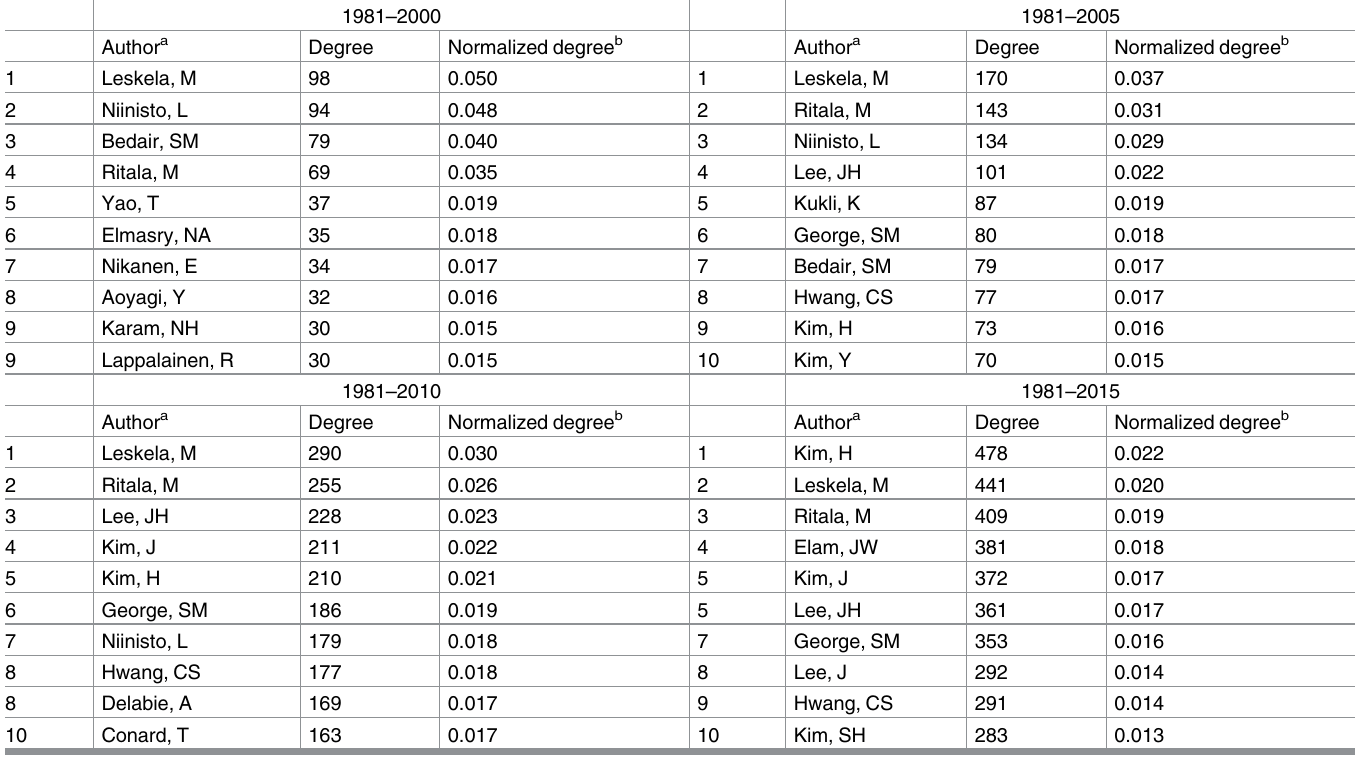
Table 6. Top 10 authors based on degree